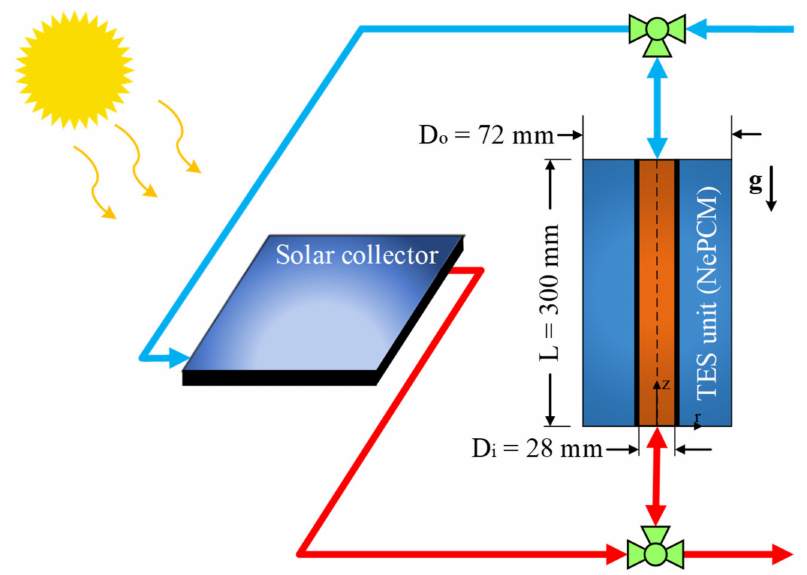
Figure 2. Schematic of a shell and tube LHTES unit in a solar thermal storage system.